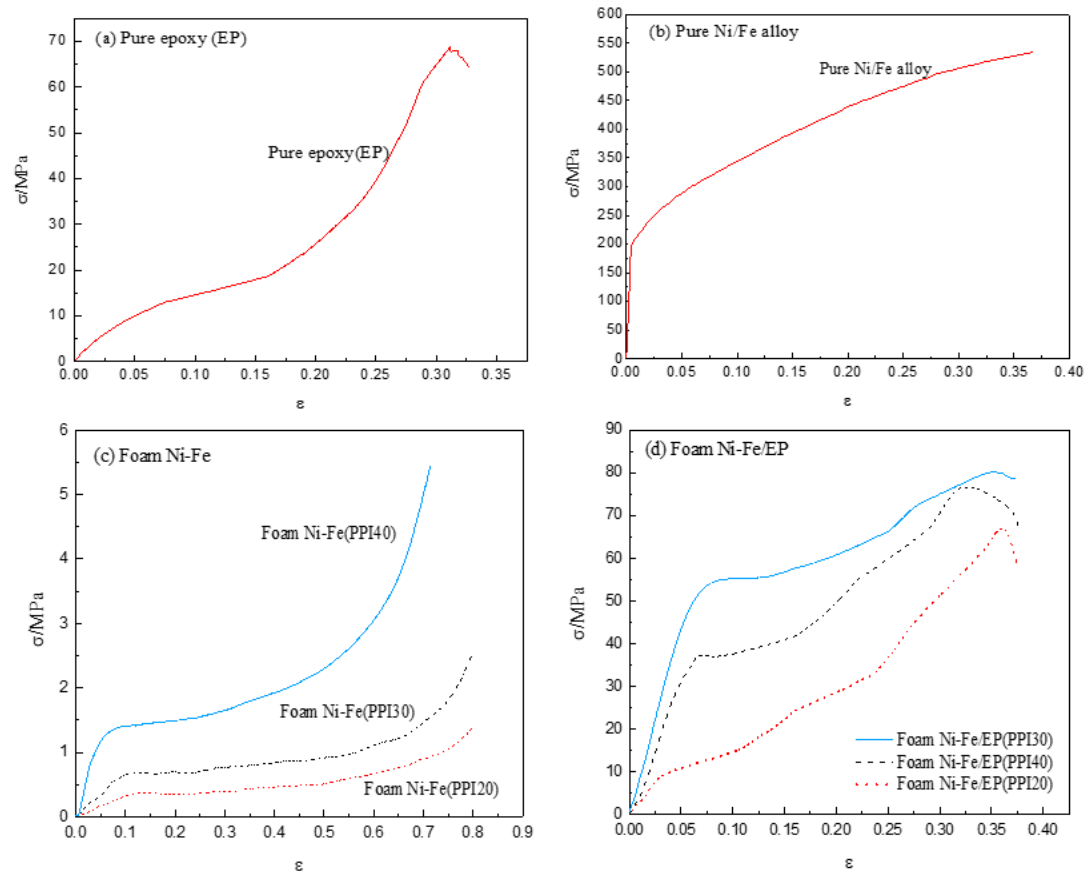
Figure 6. Stress–strain curves of pure epoxy ( a ), pure Ni-Fe ( b ), pure foam Ni-Fe ( c ), and foam Ni-Fe/EP interpenetrating phase composites ( d ).